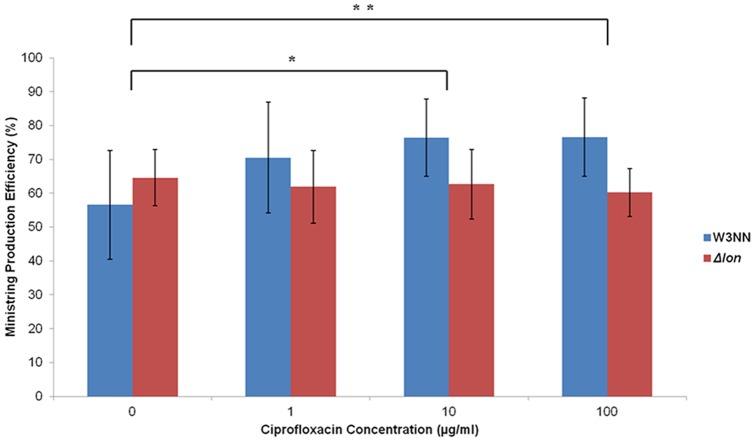
Ministring DNA production efficiency upon the introduction of ciprofloxacin at various concentrations.Application of 0, 1, 10 and 100 µg/ml of ciprofloxacin added to wild type Tel+ cells (W3NN) and Δlon derivative harboring the parental pNN9 plasmid. Addition of 10 and 100 µg/ml of ciprofloxacin added to Tel+ cells conferred a 19.8% * (P<0.10) and 20.0% ** (P<0.10) increase in DNA ministring production efficiency compared to the untreated induced control. Increases to ministring production efficiency were not observed for Δlon derivative.